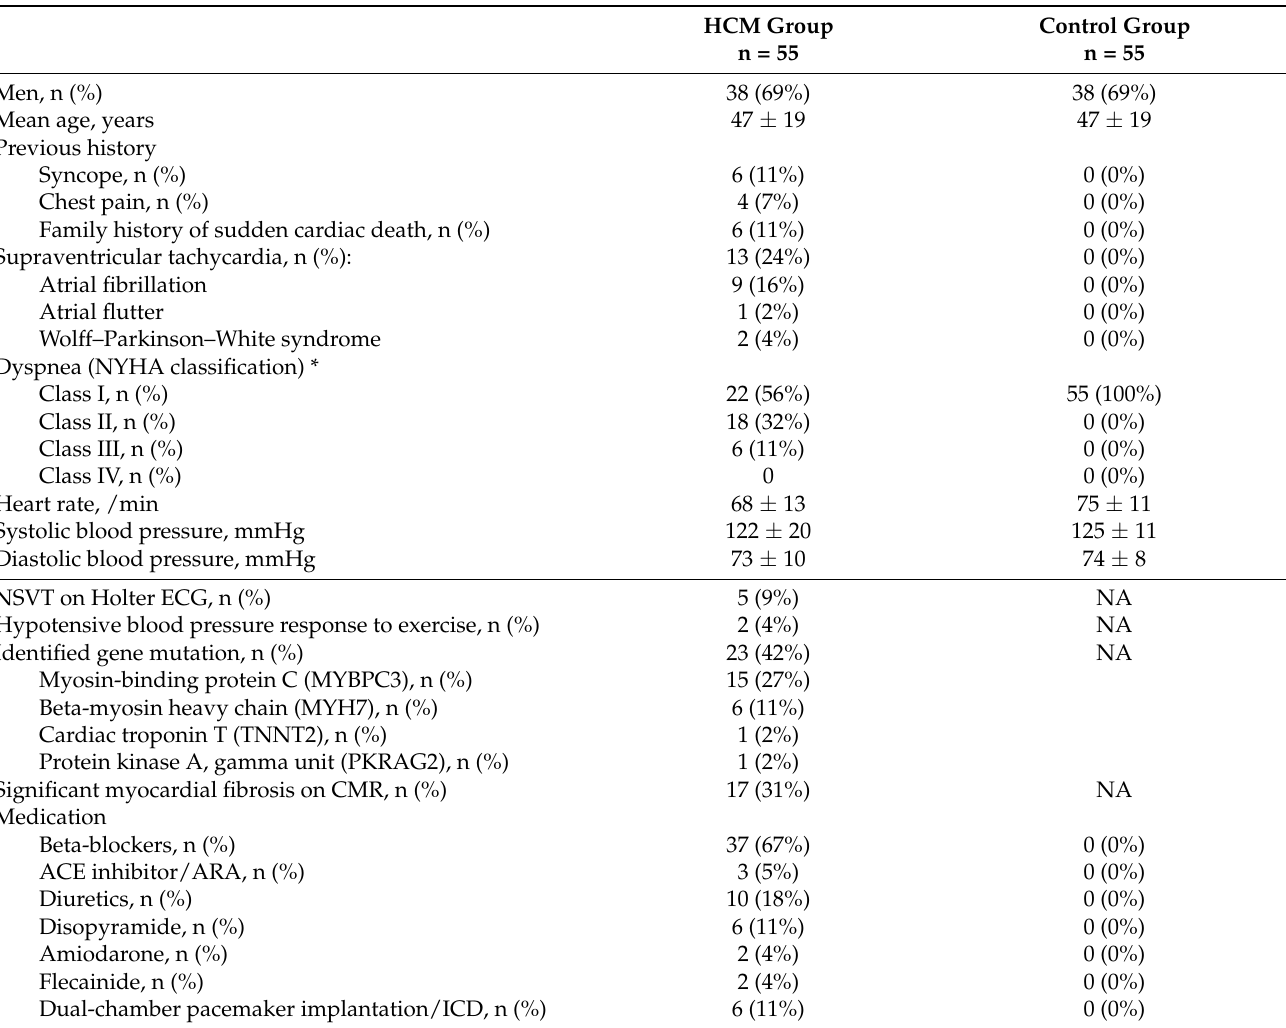
Table 1. Clinical characteristics of HCM group and control group.